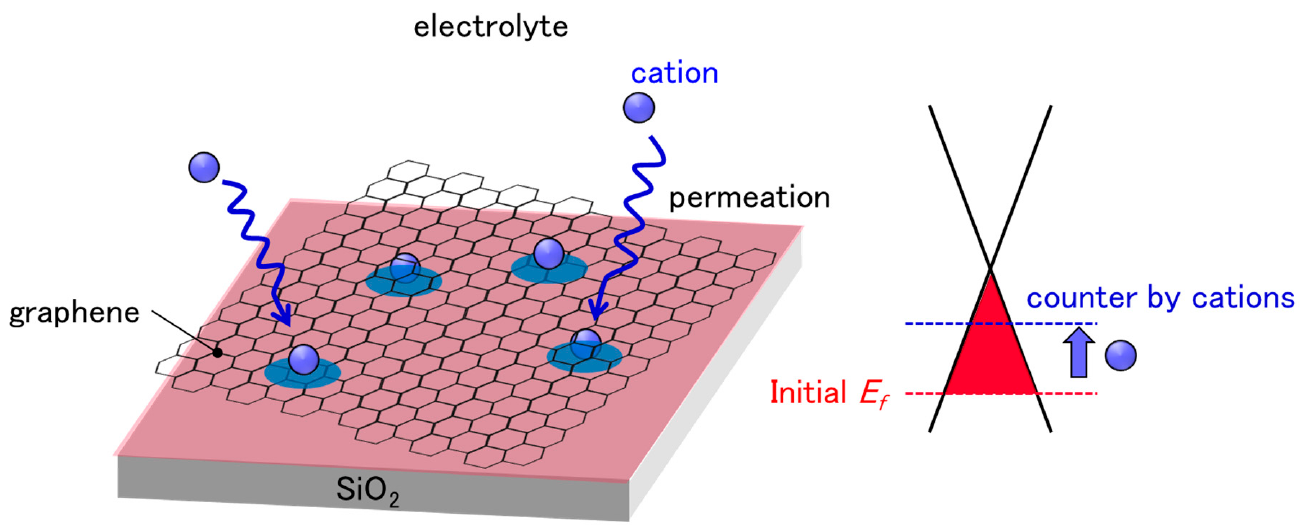
Figure 1. Schematic illustration of cation permeation into polymer residue and/or between graphene and SiO 2 substrates. Graphene is initially p-doped by the effect of PMMA residue and SiO 2 substrate. The diffusion of cations, which have n-doping effects to graphene, has a counter-effect on initial p-doping, resulting in CNP drifts.